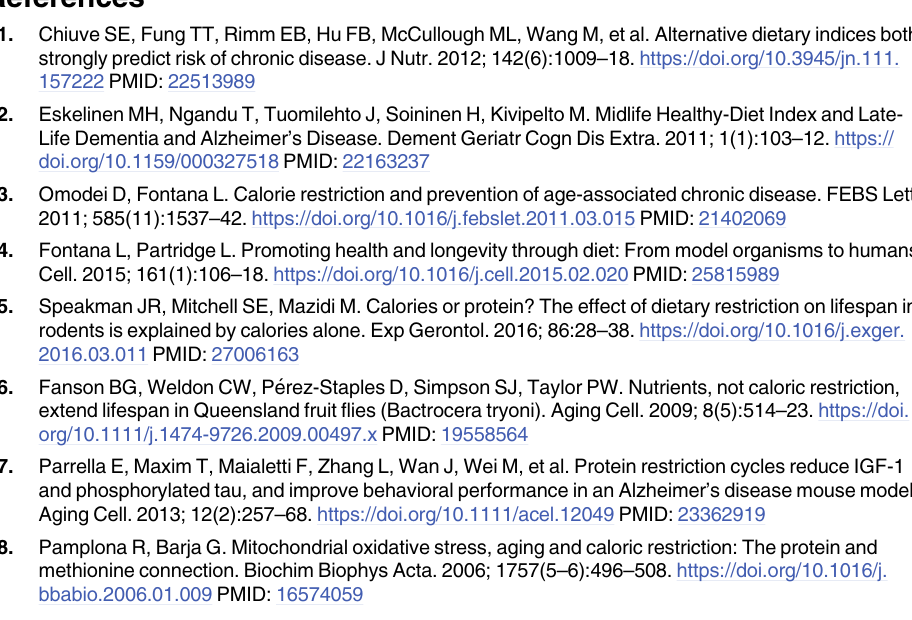
S1 Fig. Chromatograms of NAD+, NADH and NADP+ measured by liquid chromatogra- phy coupled to tandem mass spectrometry (LC/MS/MS)